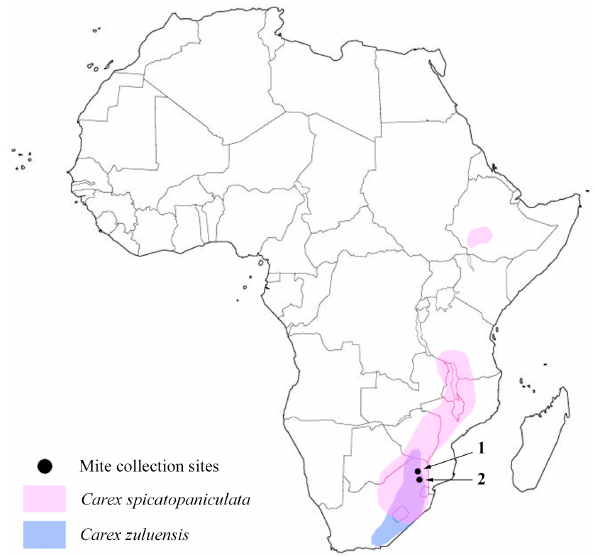
Figure 5. Estimated distributions of Carex spicatopaniculata and C. zuluensis (based on open data source from www.gbif.org , africanplantdatabase.ch , and www.inaturalist.org accessed on 22 November 2022) and collection sites of N. limpopoensis n. sp . (1) and N. zuluensis n. sp. (2) in Africa . Opisthosoma vermiform, slightly expanded caudally, widest at level of tubercles f , with 110 (104–116) dorsal and 92 (84–100) ventral annuli with elongated microtubercles;